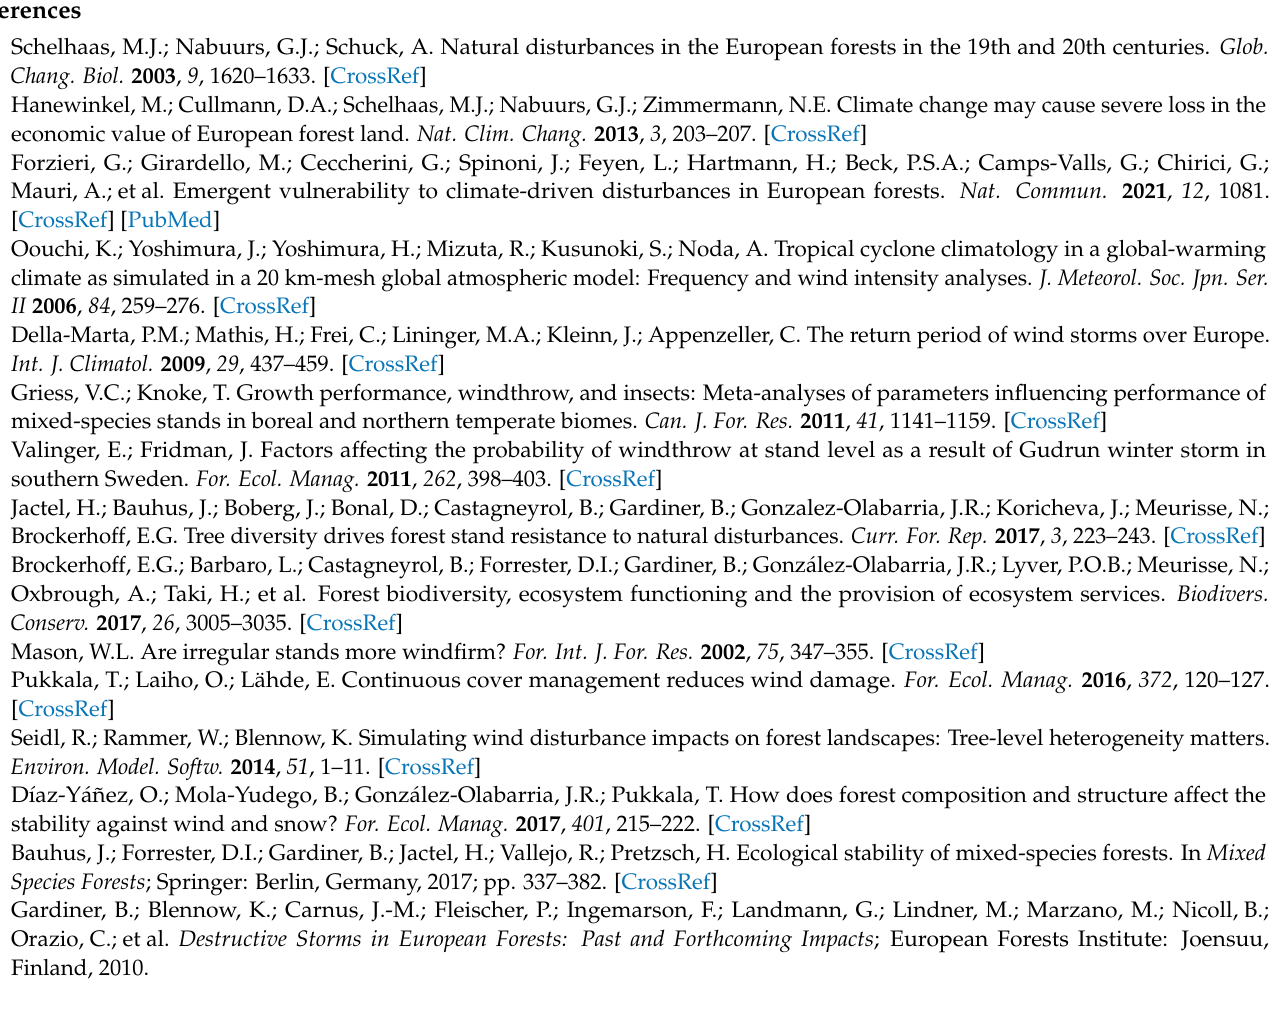
test setup, Figure S2: A scheme of the placement of motor-winch in the static pulling test